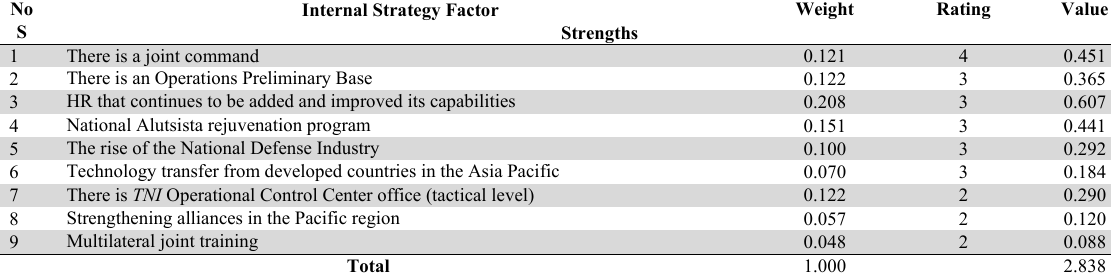
Scores and Weights for Internal Factors in Strengths Aspects No